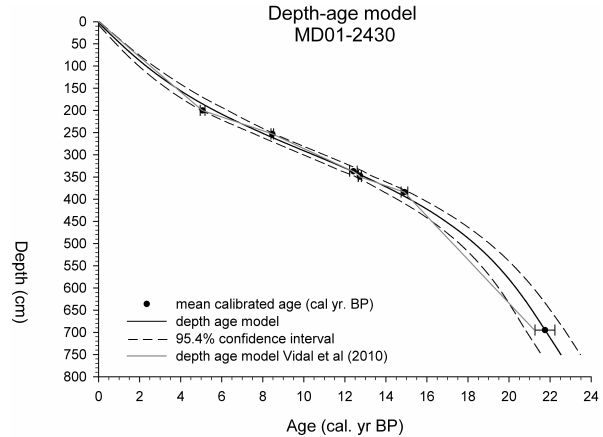
Fig. 2. Depth–age model (line) and 95.4% confidence intervals (dashed lines). Calibrated radiocarbon dates are represented by dots. Depth-age model by Vidal et al. (2010) is in